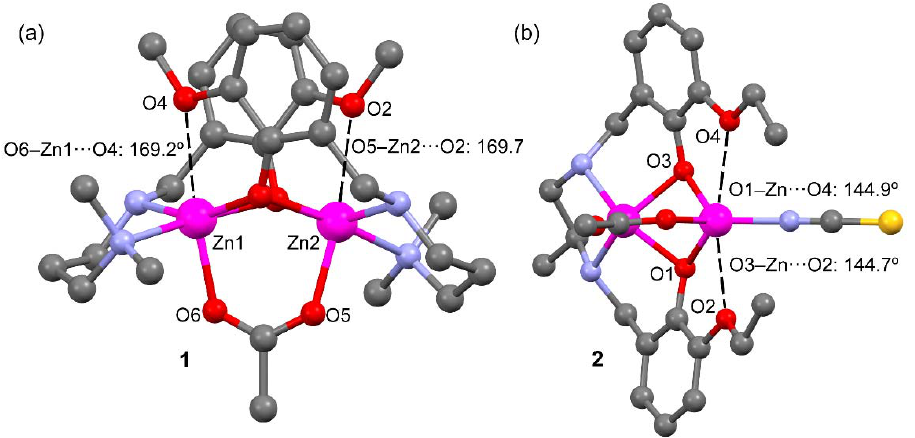
Figure 3. Spodium bonds (black dashed lines) and interacting angles in compounds 1 ( a ) and 2 ( b ). H ‐ atoms omitted for clarity.